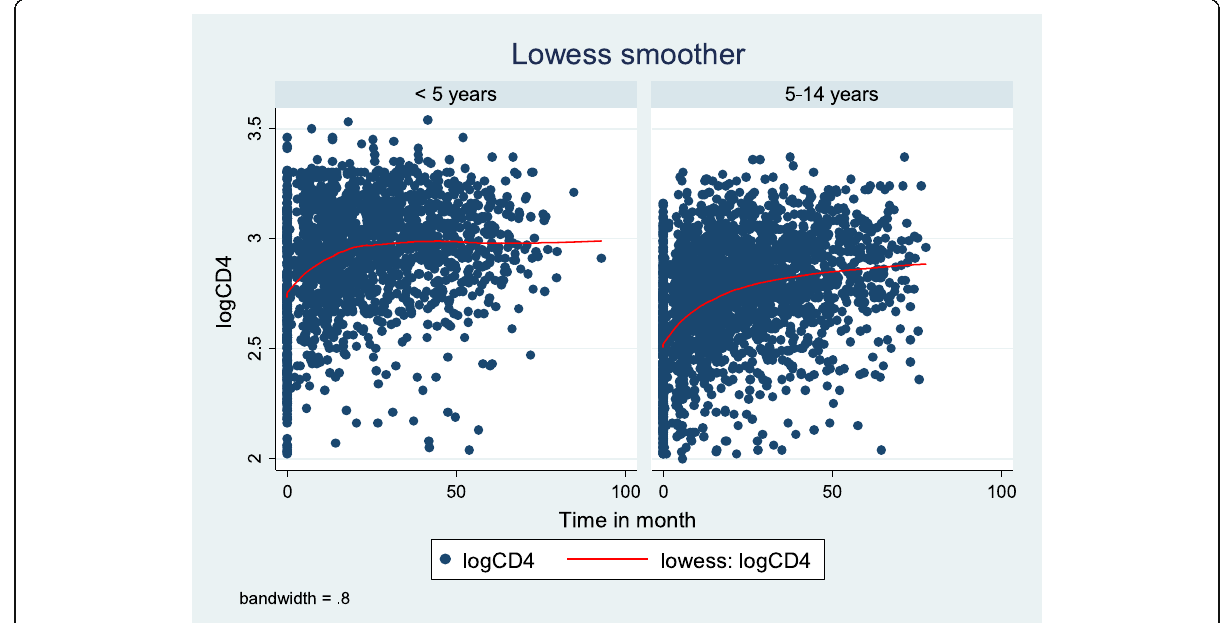
Fig. 1 Smoothing mean profile plots for the logCD4 count after the initiation of ART among children in Ethiopia stratified by age from 2010 to